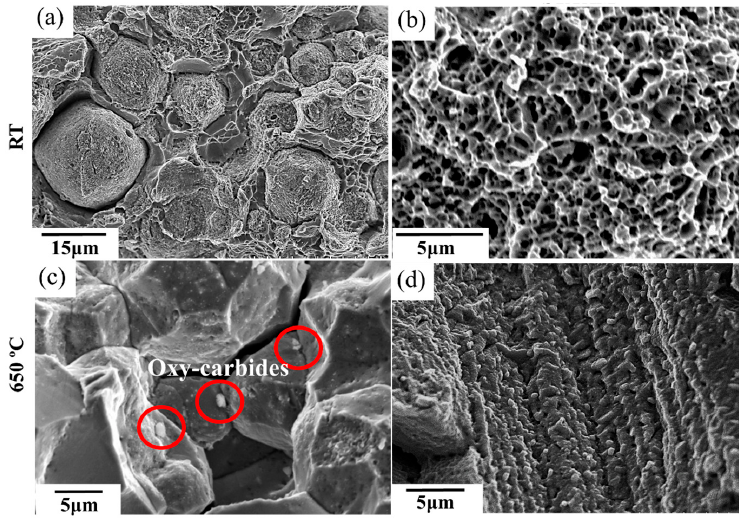
Figure 10. TEM bright field micrograph of strengthening phase precipitate within ( a ) HIP + STA and